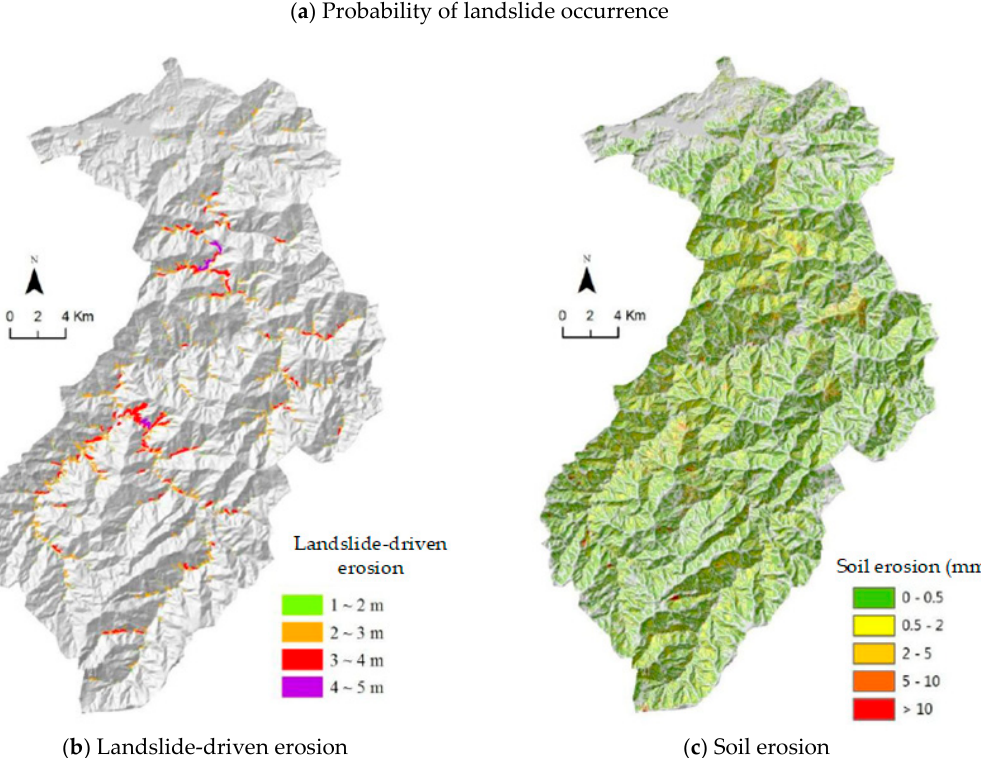
Figure 8. Results for the return periods of 200 years in the Shihmen Reservoir Watershed. Table 5. Predicted sediment production under different rainfall return periods.